Question: In one sentence, what is this figure communicating?
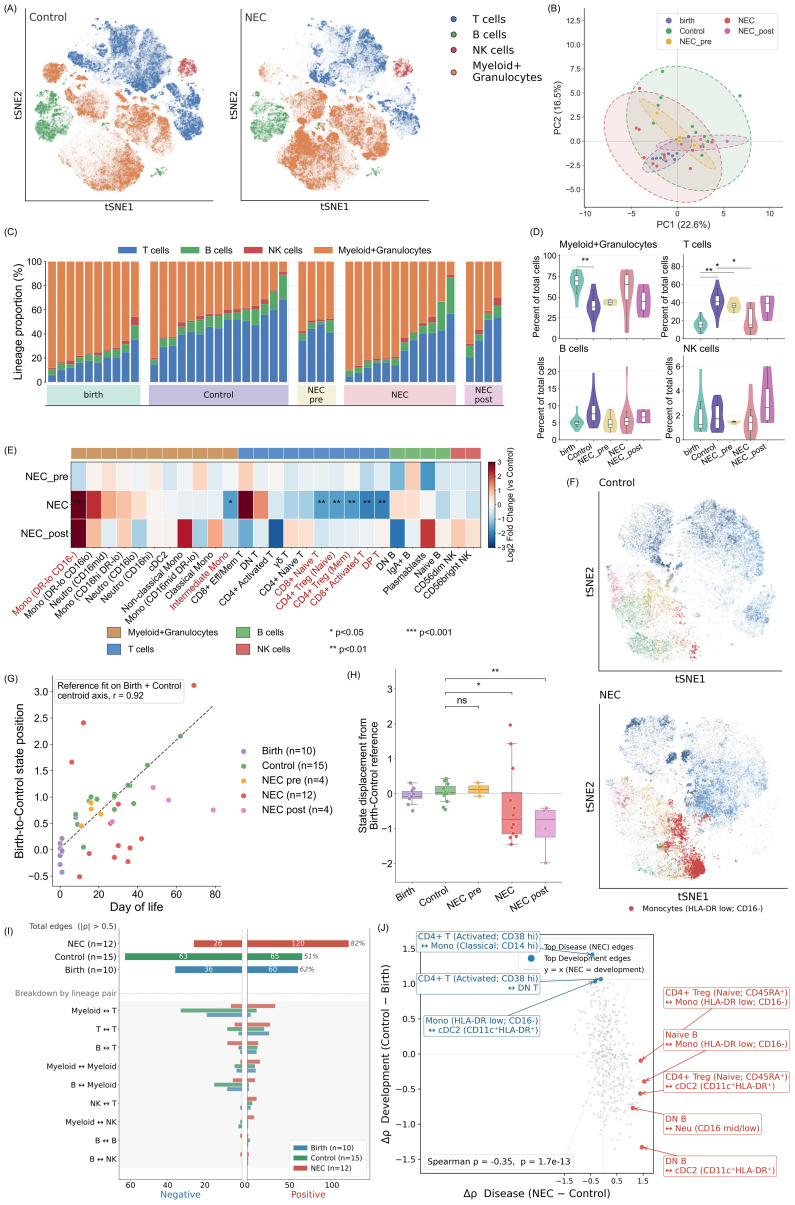
Answer: NEC onset displaces the neonatal immune landscape toward an HLA-DR-low monocyte state. (A) Global tSNE projections comparing Control and NEC samples at the lineage level. (B) Principal-component analysis of immune-cell composition across Birth, Control, NEC-pre, NEC, and NEC-post groups, with 95% confidence ellipses. (C) Major-lineage proportions across individual samples ordered by group. (D) Group distributions of major-lineage proportions. (E) Subtype-level log2 fold changes versus Control across NEC-pre, NEC, and NEC-post samples, displayed as a heatmap with lineage-colored column annotations; asterisks indicate statistically significant differences after multiple-testing correction. (F) tSNE projections highlighting HLA-DR-low CD16-negative monocytes in Control and NEC samples. (G) Birth-to-Control immune-state position plotted against day of life; the dashed line indicates the reference fit derived from Birth and Control samples. (H) State displacement, defined as observed minus DOL-expected state position, across the five groups. (I) Directional breakdown of network-edge signs across Birth, Control, and NEC samples. (J) Edge-level comparison of development-associated changes and NEC-associated changes in pairwise immune-cell correlations; highlighted edges indicate representative development-associated and NEC-associated rewiring events. The global edge-level association is shown descriptively, while specific rewired edges were evaluated using Fisher r-to-z testing with false-discovery-rate correction. CD, cluster of differentiation; DOL, day of life; HLA-DR, human leukocyte antigen-DR; NEC, necrotizing enterocolitis; PCA, principal-component analysis; tSNE, t-distributed stochastic neighbor embedding.